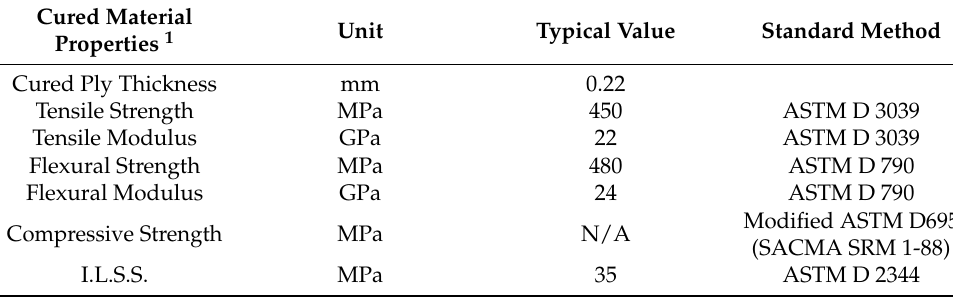
Table 2. Mechanical Properties of Glass